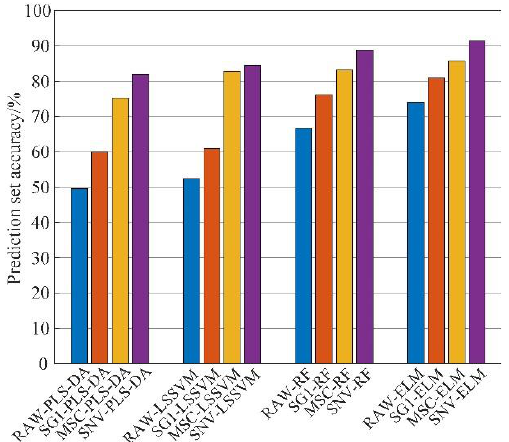
Figure 5. Modeling analysis results based on full wavelength.